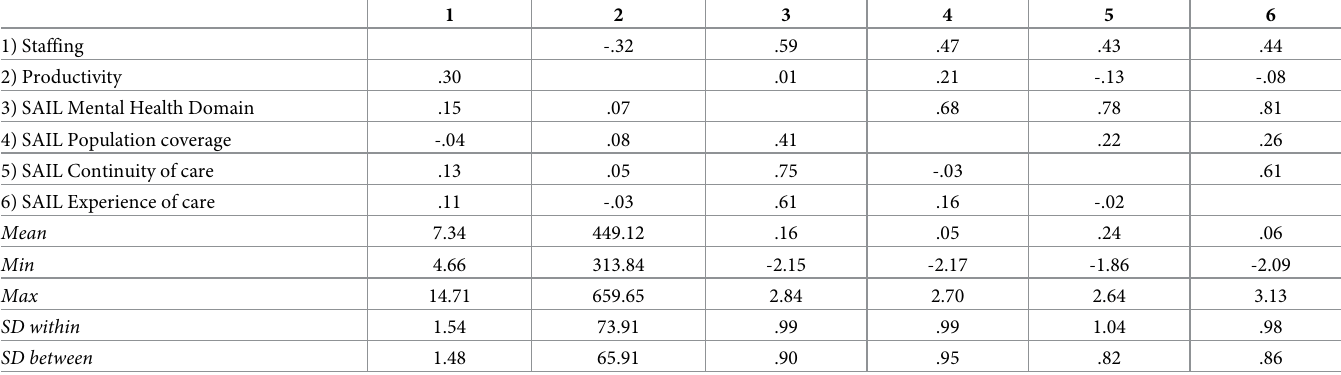
Table 1. Between-facility correlations (above the diagonal) and within-facility correlations (below the diagonal) and descriptive statistics for all variables included in the study.